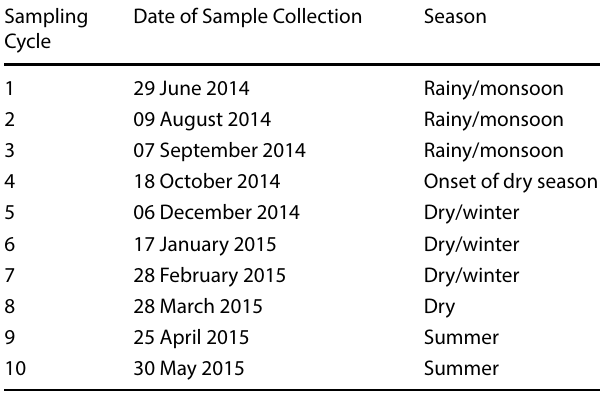
Table 2 Sampling schedule for characterization of Hatirjheel water Sampling